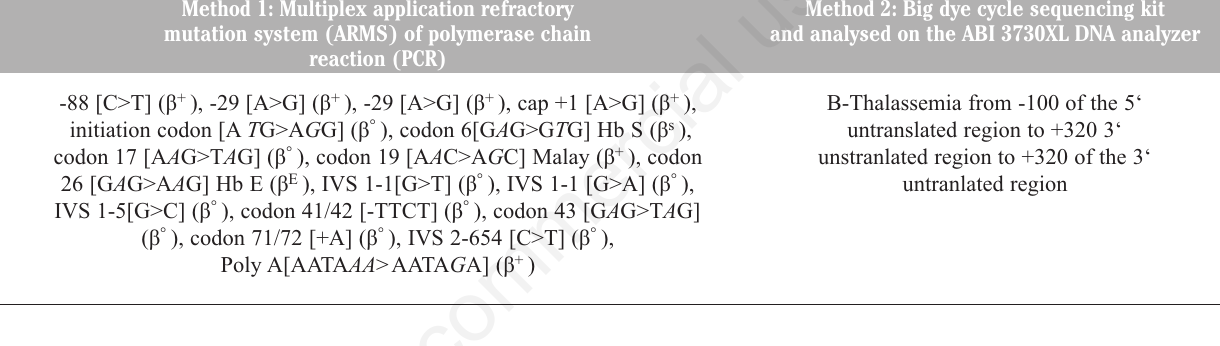
Table 1. DNA analysis of b -globin gene/cluster and test methods conducted at Institute for Medical Research (Malaysia) Laboratory. Method 1: Multiplex application refractory Method 2: Big dye cycle sequencing kit mutation system (ARMS) of polymerase chain and analysed on the ABI 3730XL DNA analyzer reaction